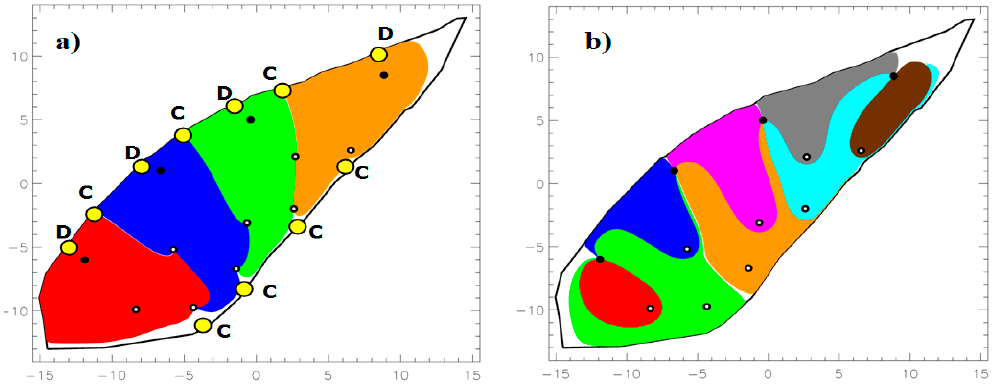
Figure 4. CAM simulations. ( a ) Injector partitions with colour segments showing individual sectors swept by each injector. Yellow dots are flow stagnation points with either divergent (D) or convergent (C) flow. ( b ) Producer partitions with colour segments marking individual sectors drained by each producer. Stagnation points occur along the periphery of the bounded domain and between producer wells. Reproduced with permission from [3].